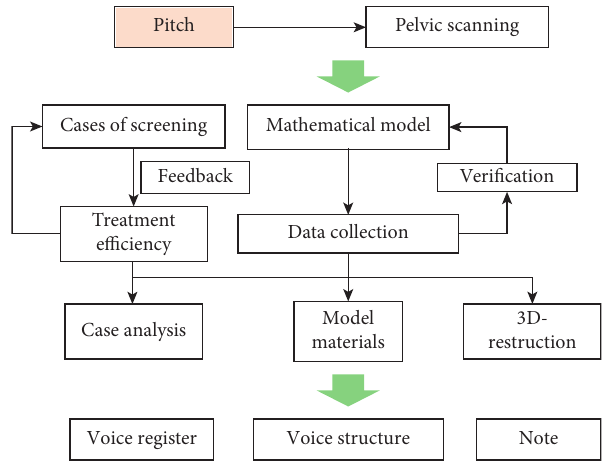
Figure 4: List of difficulty characteristics of the